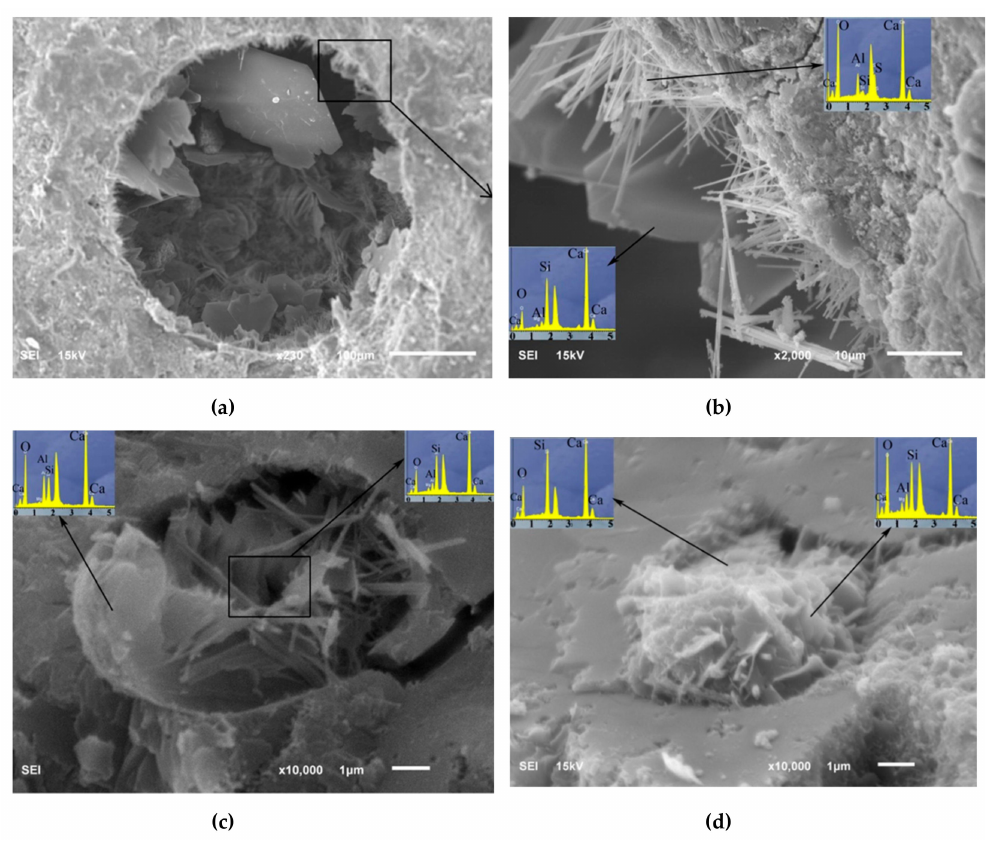
Figure 31. SEM-EDX results of the microstructure of GO composite pores in: ( a ) 0.06% GO composite, ( b ) amplification of (a) showing a surface growth nature of ettringite and flakes structures, ( c ) a small pore of 0.02% GO and ( d ) a small pore of 0.04% GO. Reprinted with permission from [162]. Copyright © 2019, Elsevier B.V.